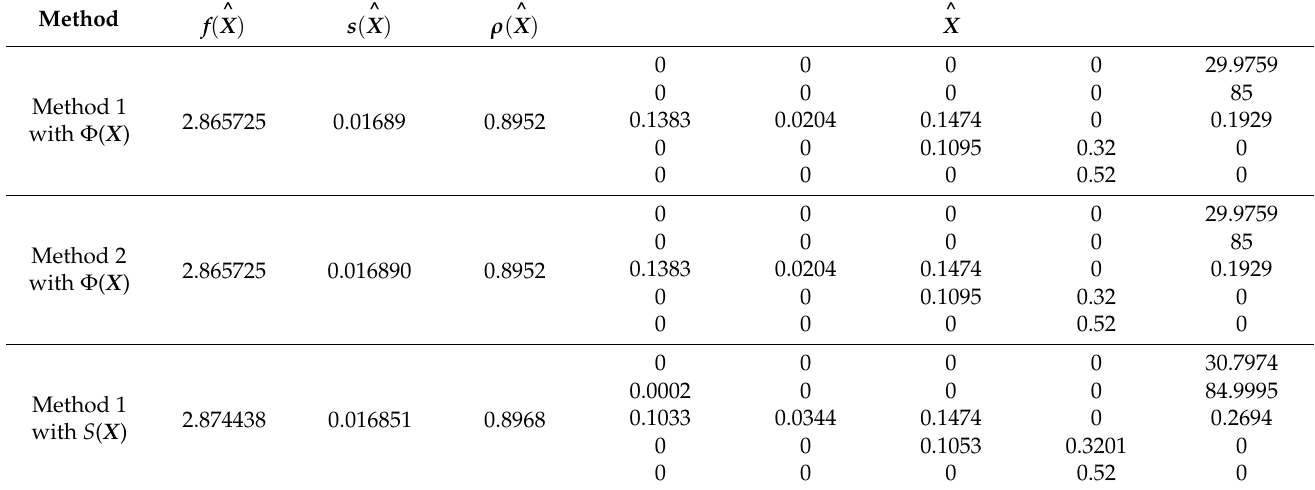
Table 5. Results for Example